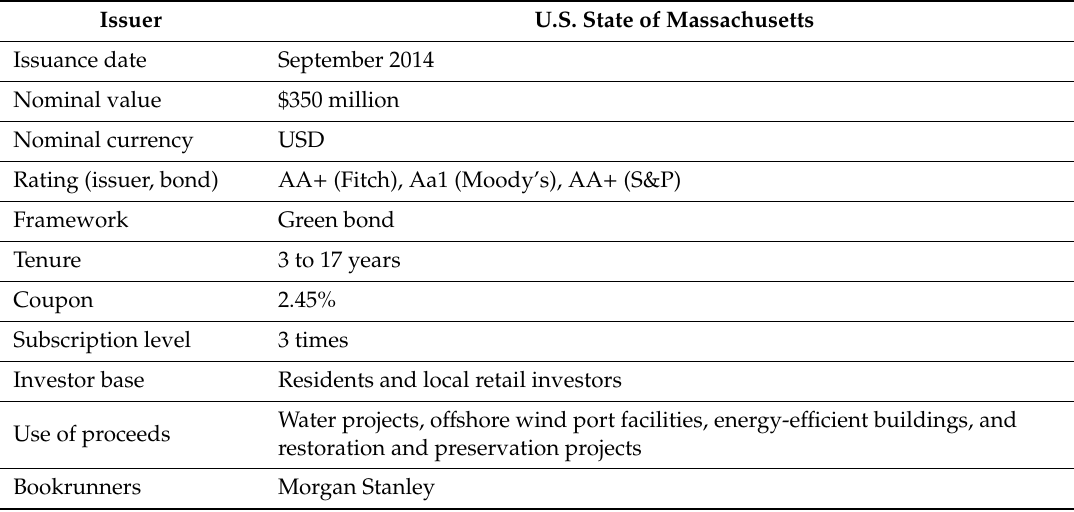
Table A2. The 2014 U.S. State of Massachusetts’s green bond.